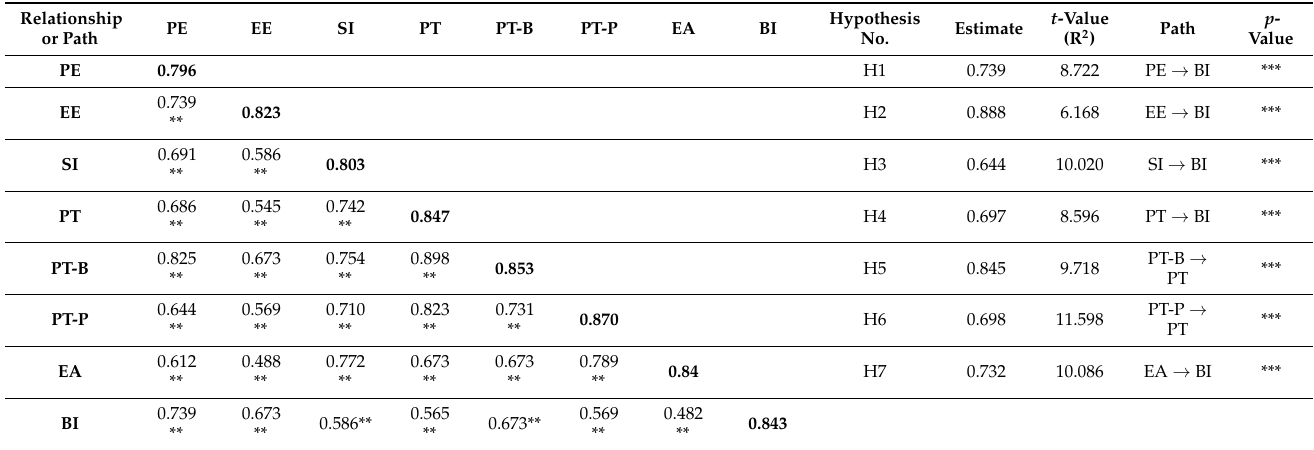
Table 4. Correlation matrix and discriminant validity of the measurement model, path coefficients, t -values, and p -values of the